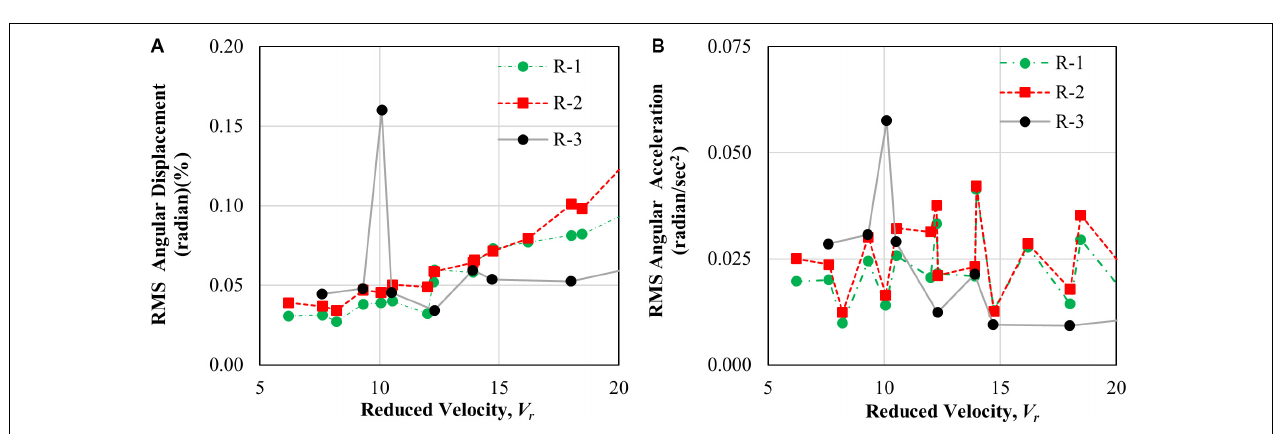
FIGURE 12 | The response curve of the current study. (A) Displacement, (B)